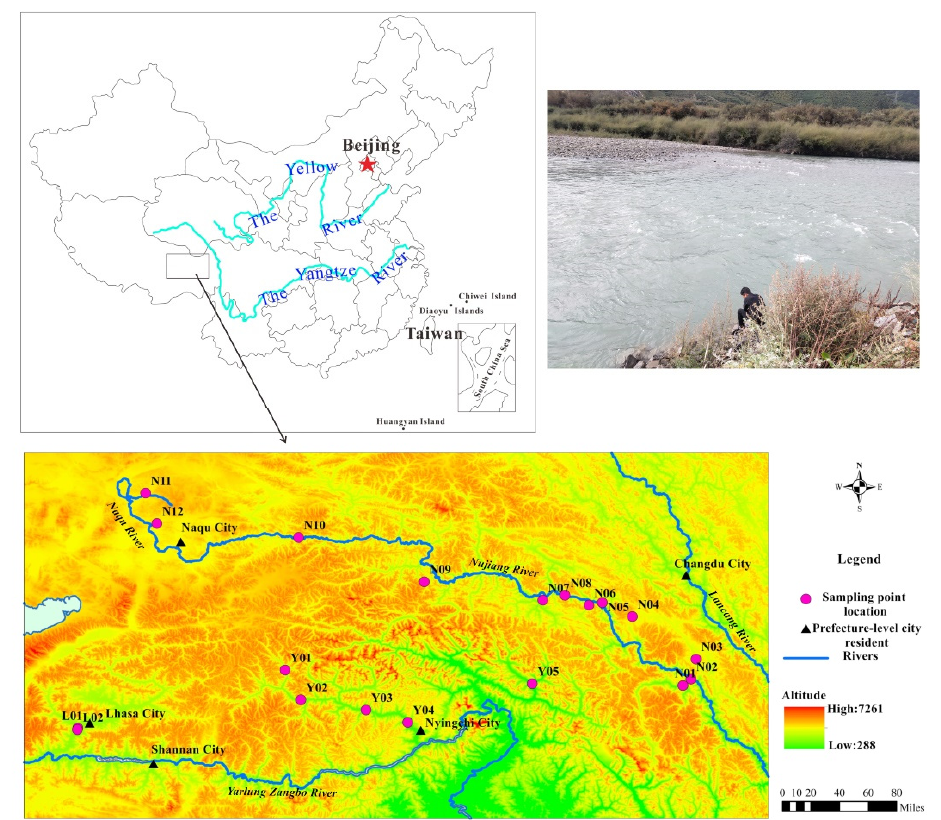
Figure 1. Geographical location and distribution of sampling points in the study area.